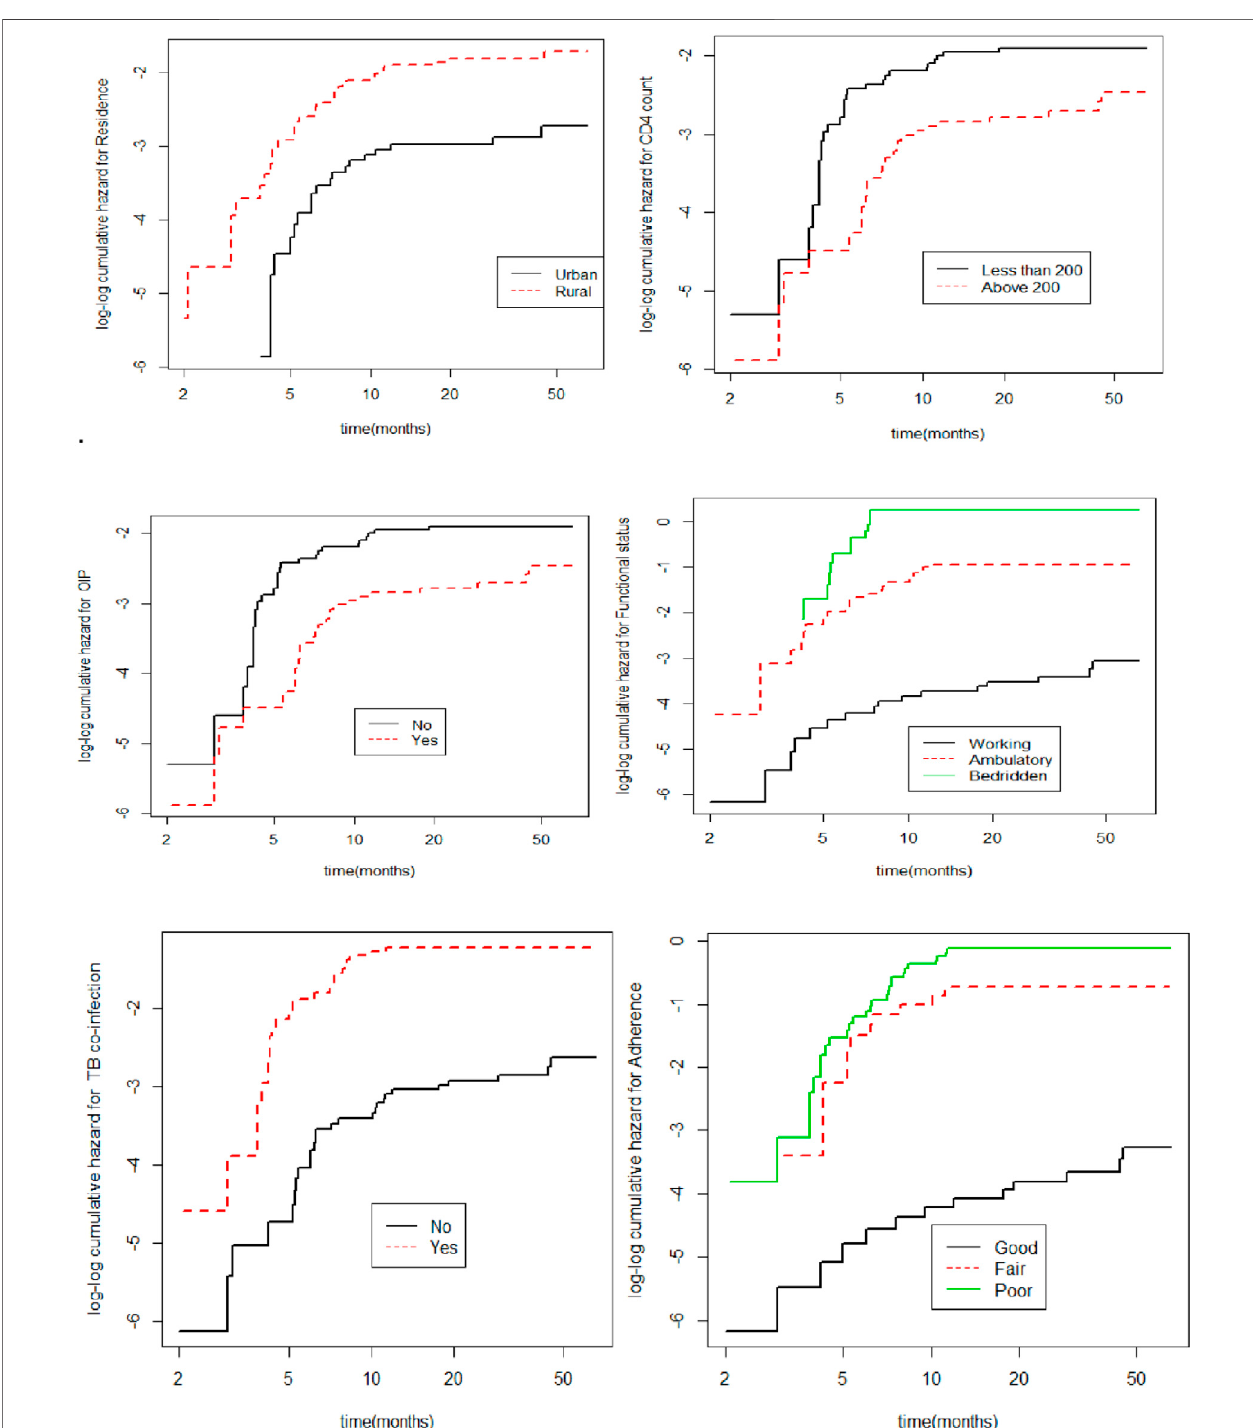
Figure S1 | Kaplan-Meier Survival plots for selected baseline covariates.